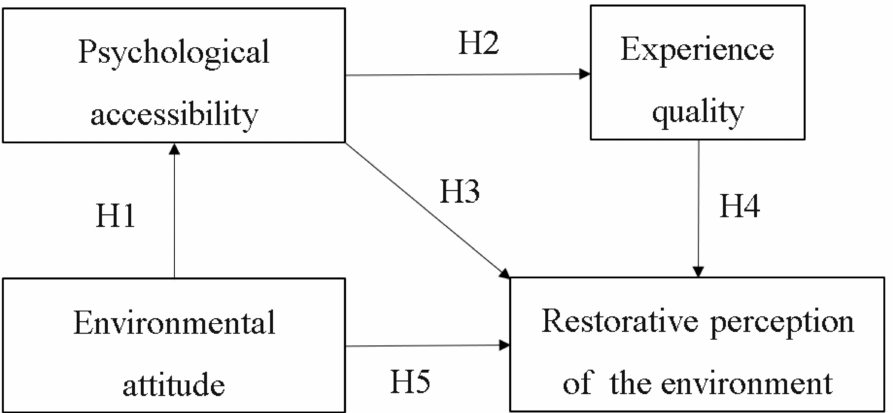
Figure 4. Model diagram of restorative perception of the environment pathways under the influence of psychological